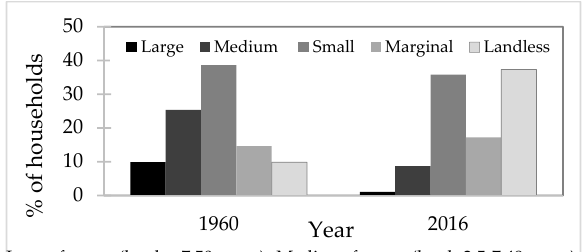
Figure 3. Number of non-farming establishments and change in agricultural farms in the study area.